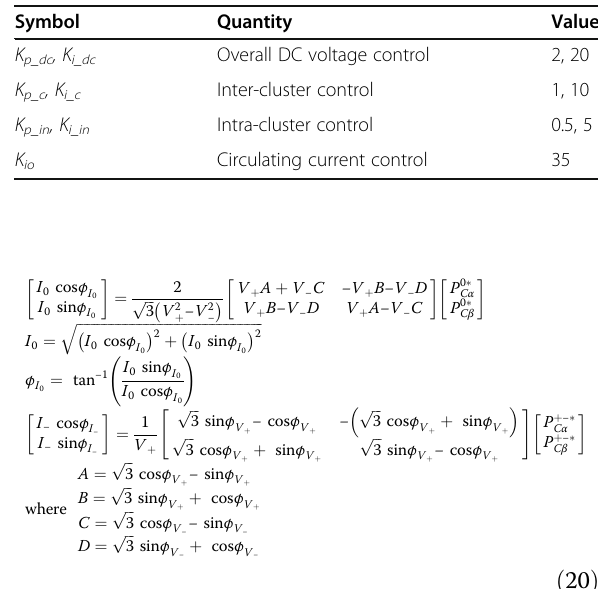
Table 2 MMCC control parameters